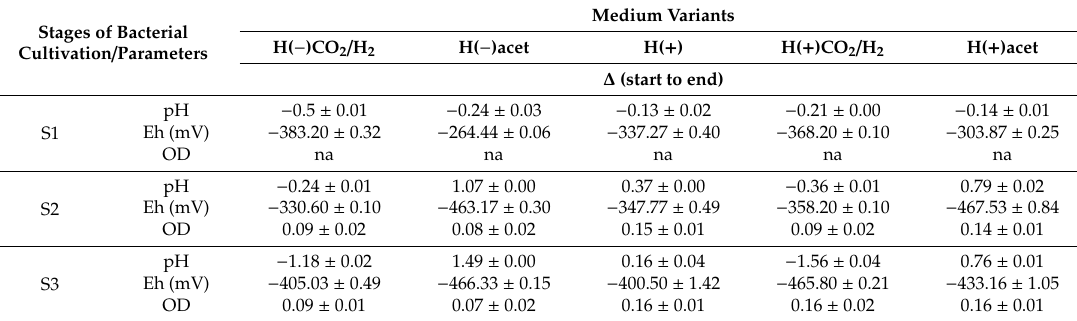
Table 3. Changes in physicochemical parameters between the start and the end of the particular stages of incubation ( ±